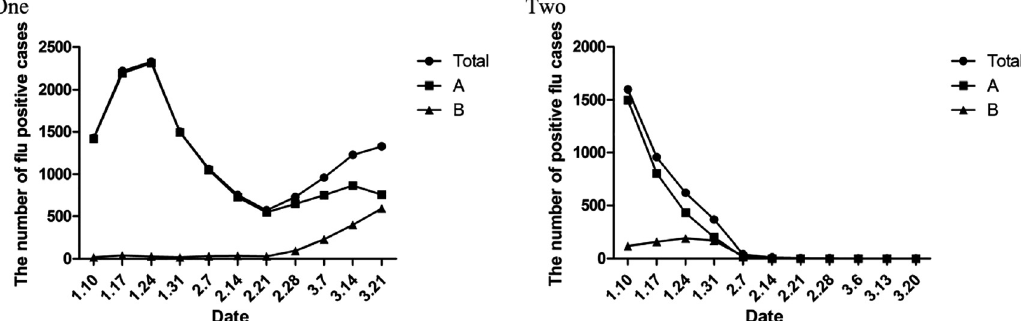
Figure 1: The trend of influenza infection in children with time in 2019 and